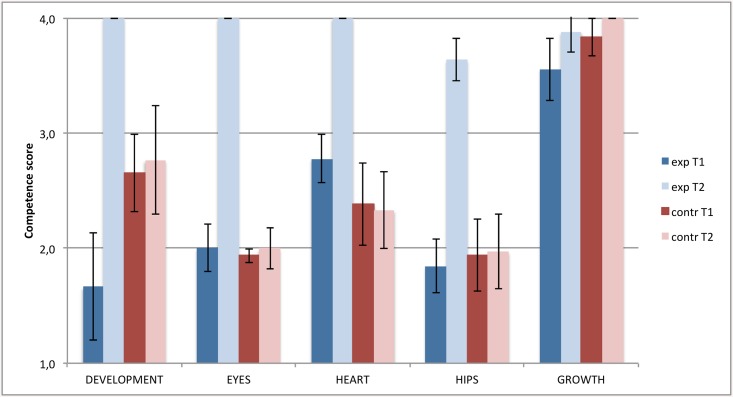
Competence of nurses to perform 5 medical screenings, experiment and control regions compared.T1 = at the start of the training, T2 = after one year experience with the new working method. Exp = experiment region, contr = control region. The 95% confidence intervals are indicated by black error bars.